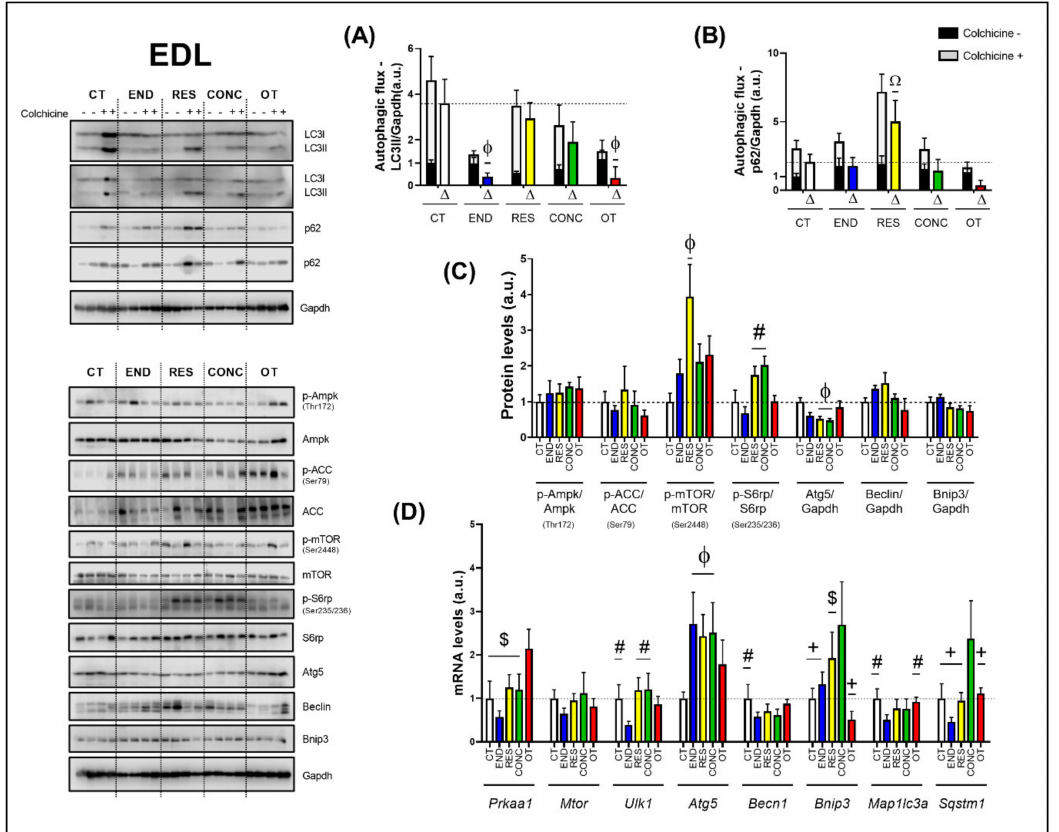
Figure 7. Autophagic flux for LC3II / Gapdh ( A ) and p62 / Gapdh ( B ) in EDL. Protein levels of p-Ampk / Ampk, p-ACC / ACC, p-mTOR / mTOR, p-S6rp / S6rp, Atg5 / Gapdh, Beclin / Gapdh, Bnip3 / Gapdh in EDL ( C ). mRNA levels of Prkaa1, Mtor, Ulk1, Atg5, Becn1, Bnip3, Map1lc3b , and Sqstm1 in EDL ( D ). Data correspond to the mean ± SEM of 4 mice / group. For autophagic flux, there are